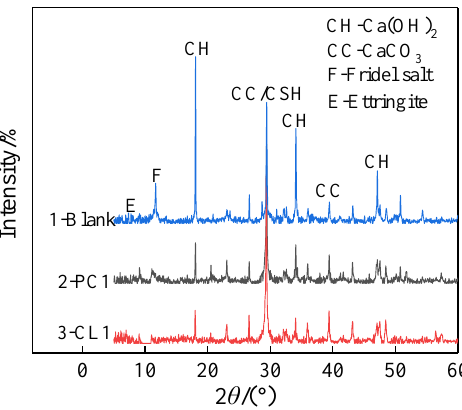
Figure 8. Effect of coatings on XRD patterns of cement hydration products.